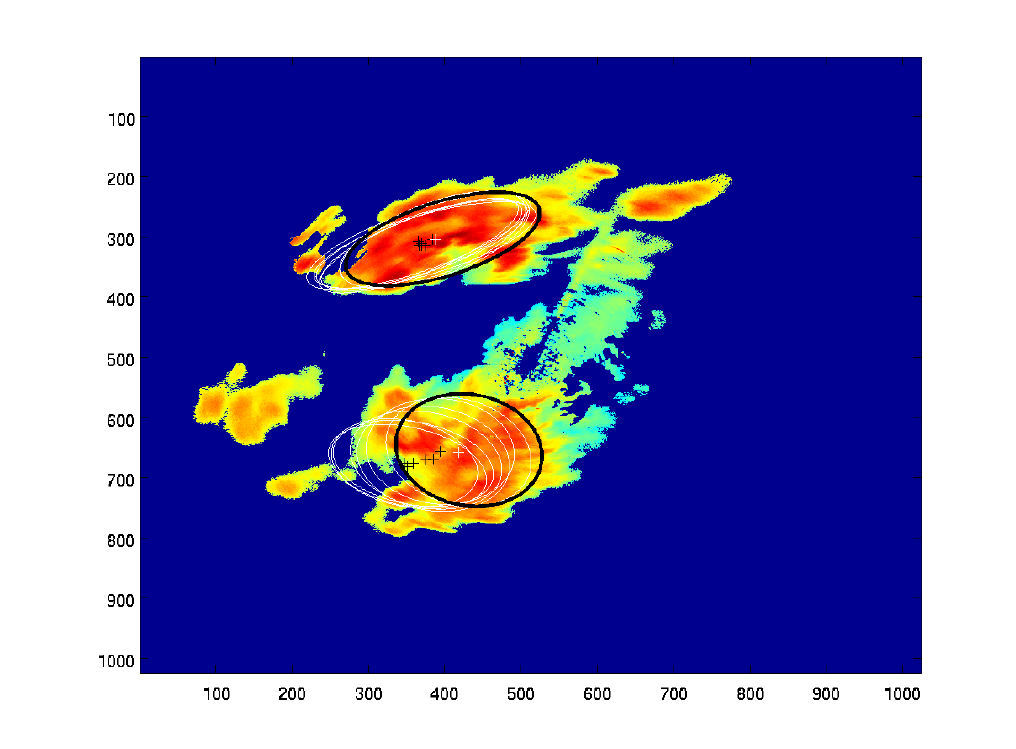
Figure 9. Storm tracks of two cells. Table 4. “Percentage correct” for different (cid:11) values, while restricting the searching space. DID (cid:11) 1 :